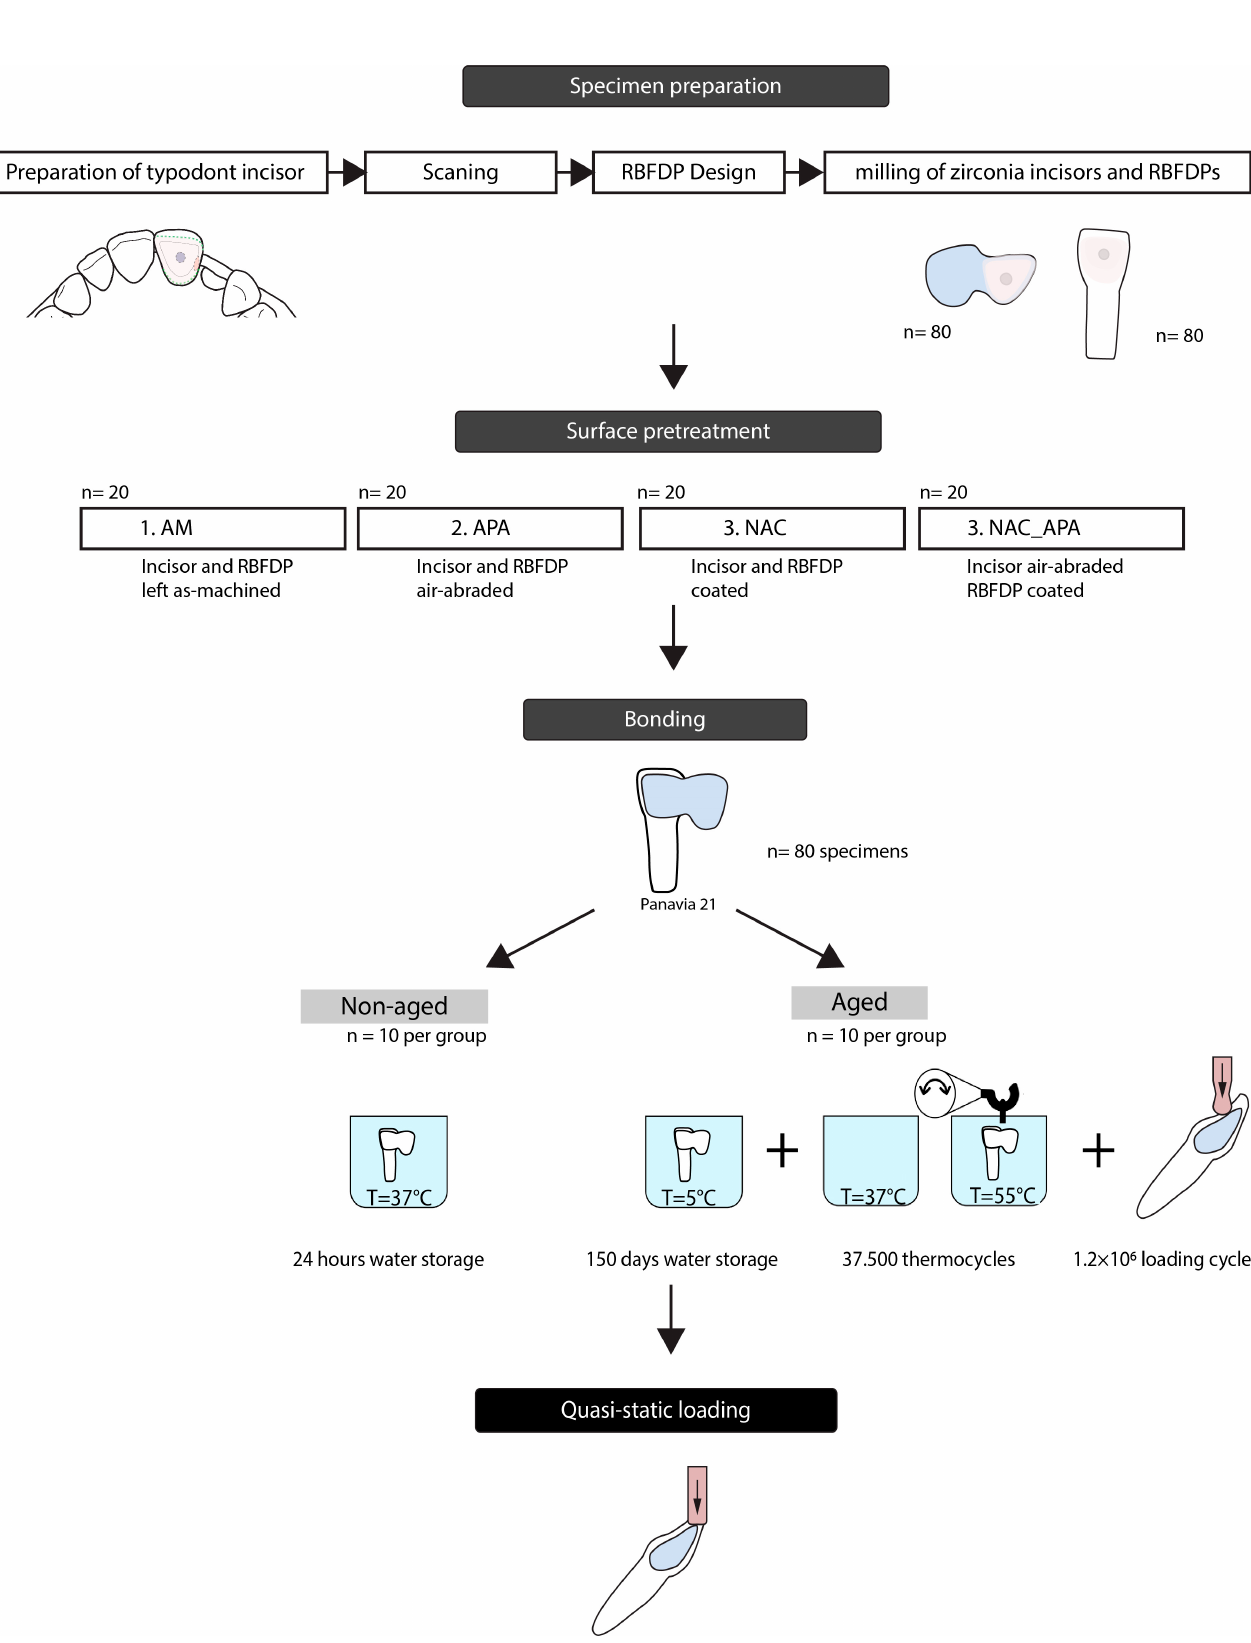
Figure 4. Experimental fl owchart .